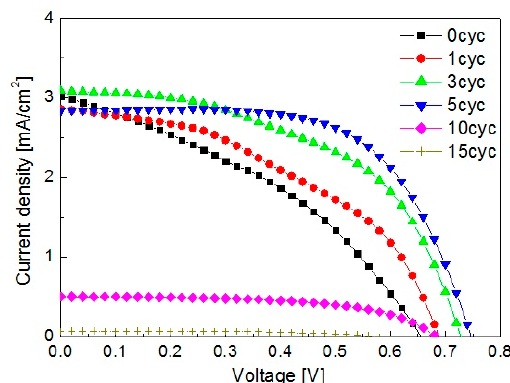
Figure 6. Photocurrent density–voltage (J–V ) curves of CdSe quantum dot-sensitized solar cells (QDSSCs), where the IO-TiO 2 is treated with (from 1 cycle to 15 cycles) and without ZnS surface passivation (0 cycle). Table 1. Dependence of the photovoltaic properties on the passivation cycles a .